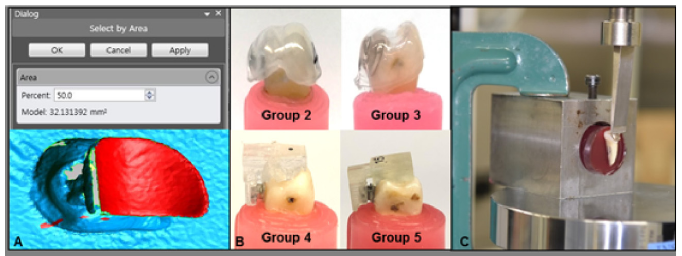
Fig 2. Bracket base calculation, indirect bonding and debonding force test. A. Measurement of bracket bonding area by 3D analysis program; B. Indirect bonding on tooth with transfer tray/jig; C. Measurement of debonding force by Instron